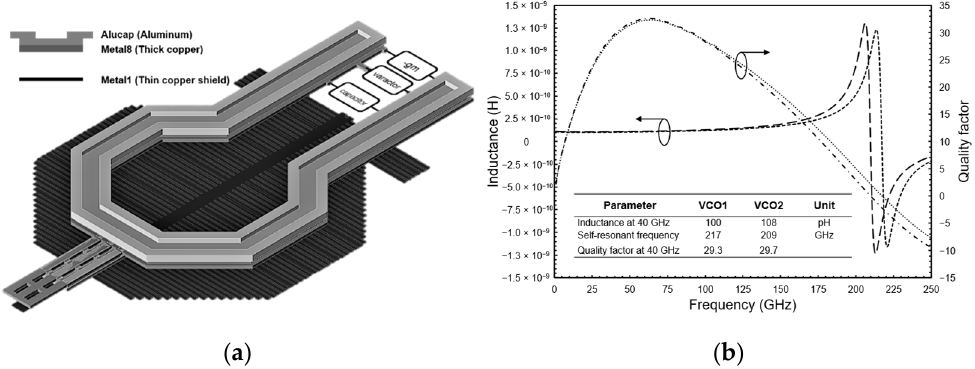
Figure 3. Single ‐ turn octagonal inductor: ( a ) 3D view with metal stack ‐ up and ( b ) simulated inductance and quality factor.